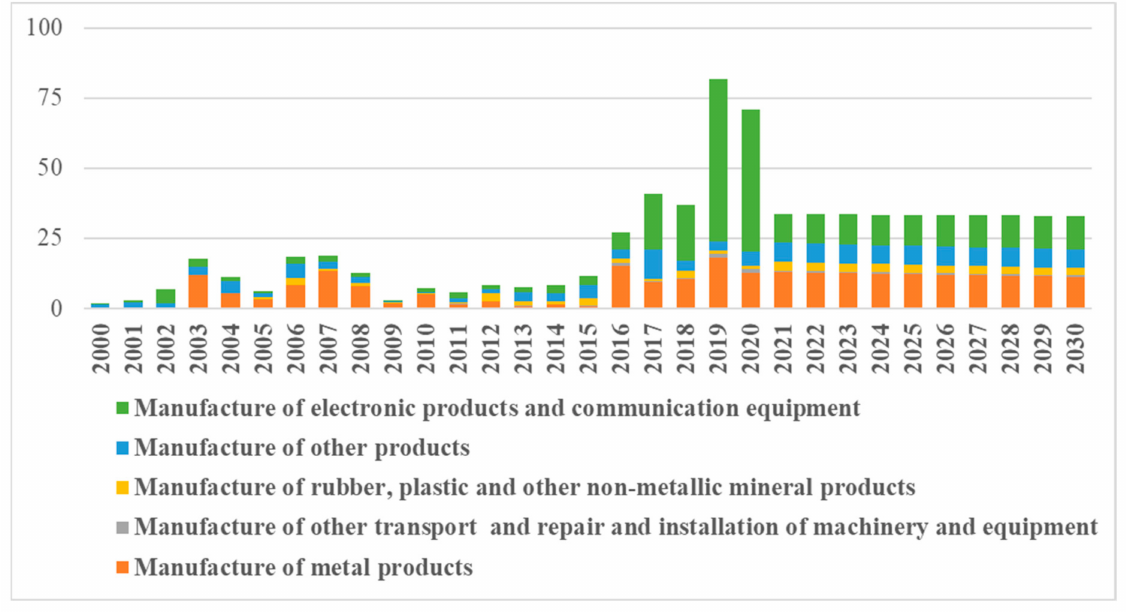
Figure 12. Real investment in tangible assets till 2030, million EUR (own estimation).